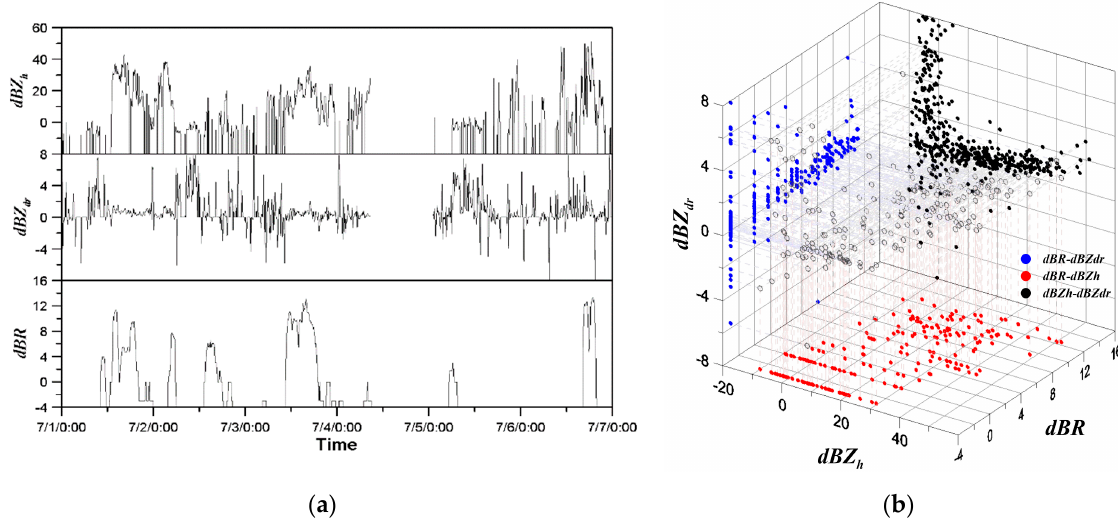
Figure 3. Time series plots and scatter plots of rain rate observed at the Shinpo rain gauge station (No. 936) for the storm event that occurred in 2016 and the corresponding radar data: ( a ) time series plots, ( b ) three-dimensional scatter plot.